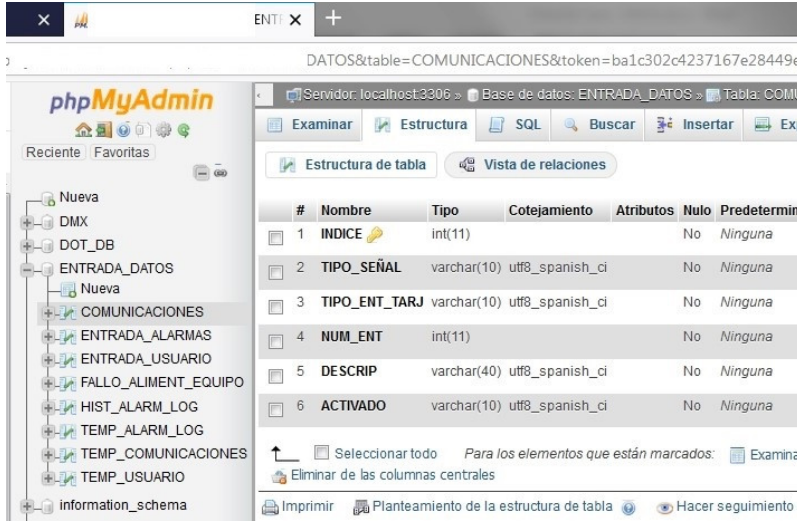
Figure 11. Platform and home control communication elements.